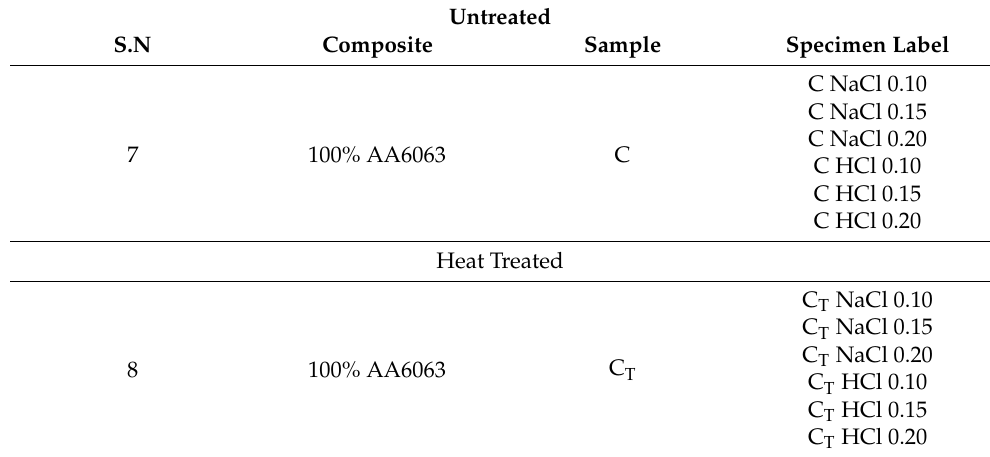
Table 4. Labels and weight of unheated and heat-treated aluminium alloy control specimens.